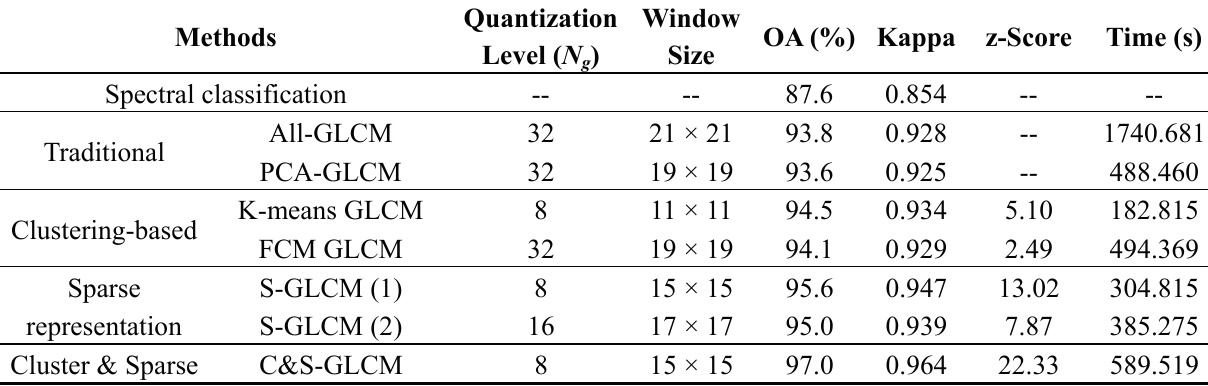
Table 7. The classification accuracies achieved by different texture extraction strategies with the optimal parameters. The z-scores between the proposed methods and PCA-GLCM are also reported (QuickBird Wuhan